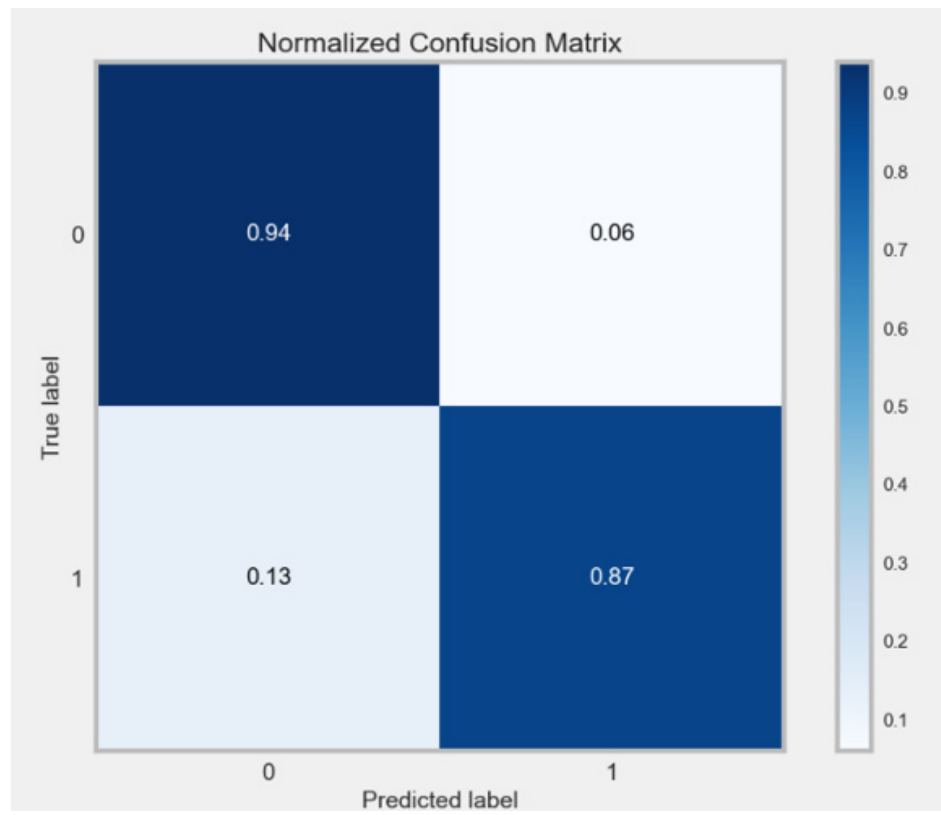
Figure 15. Normalized Confusion matrix for XGBoost model.